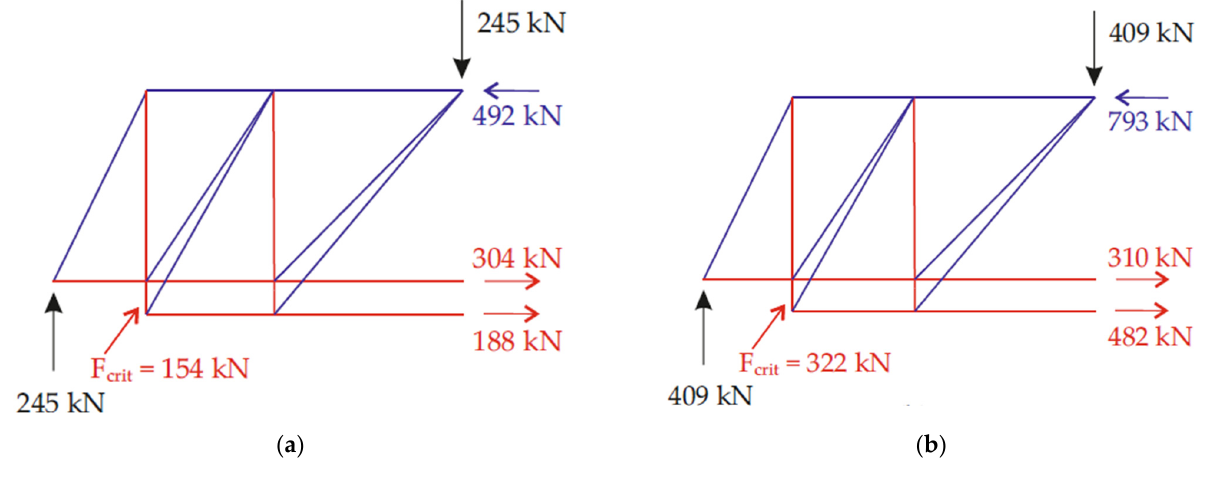
Figure 26. Tensile and compression loads of the specimens when reaching the maximum load: ( a ) specimen 1; ( b ) specimen 2. (Graphic: CARBOCON GMBH).